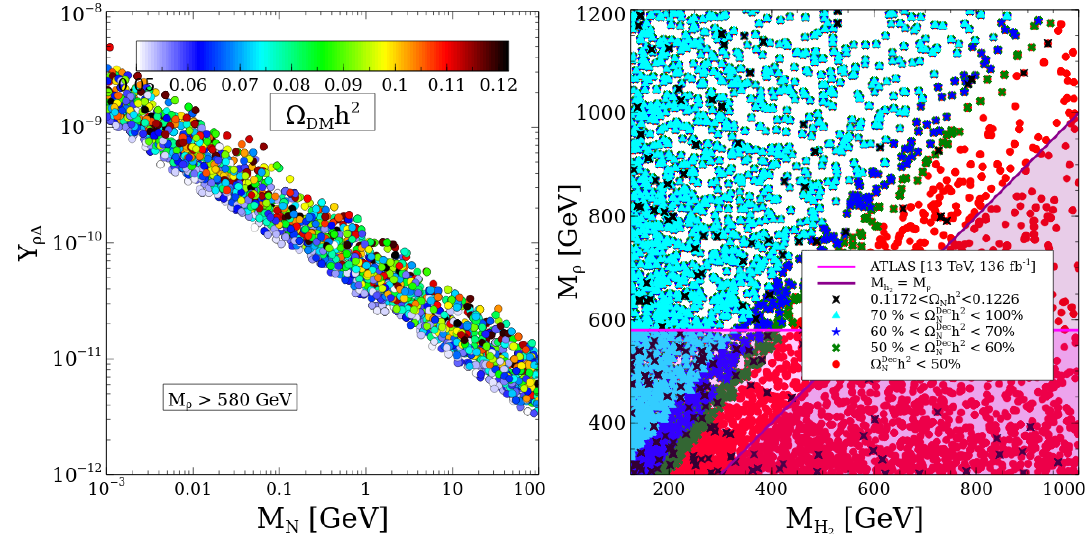
Figure 22 . LP and RP show the scatter plots in M N − Y ρ ∆ and M H color variation are due to the variation in DM relic density. All the points in LP and RP satisfy BBN